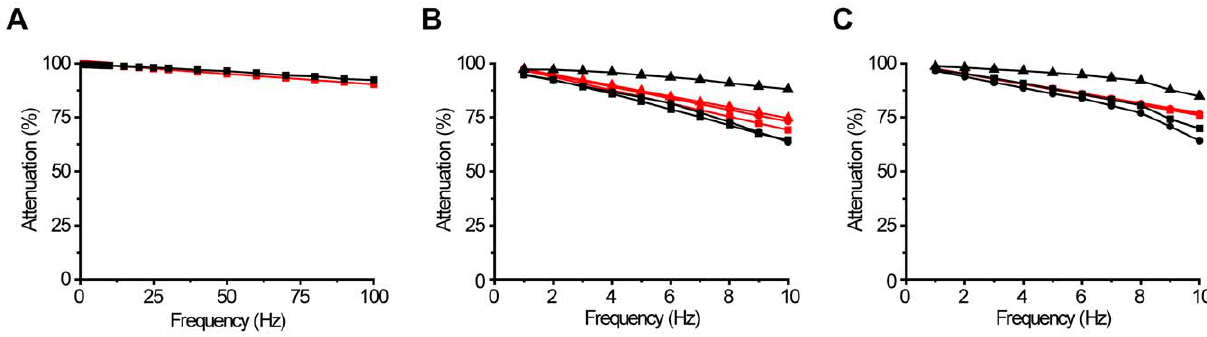
Figure 4. Simulated and measured stabilization performance. A, Measured (black) and simulated (red) movement attenuation performance of the 1D system. B, Measured (black) and simulated (red) movement attenuation performance of the 3D system for x (squares), y (circles) and z (triangles) with 5 m m movement C, Same as in B but for 10 m m movement.